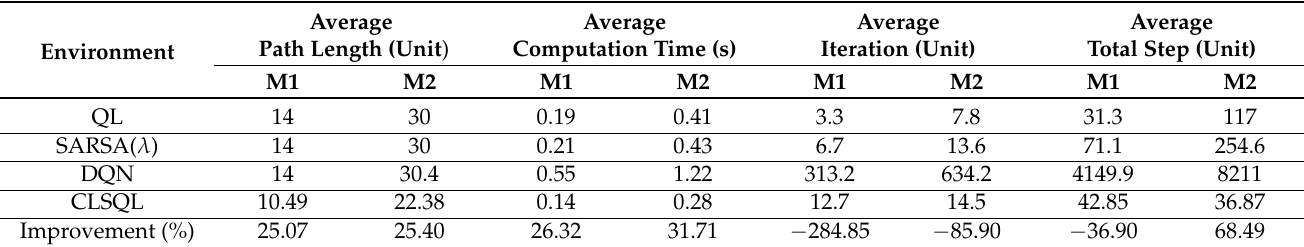
Table 5. Average Performance Comparison of Obstacle